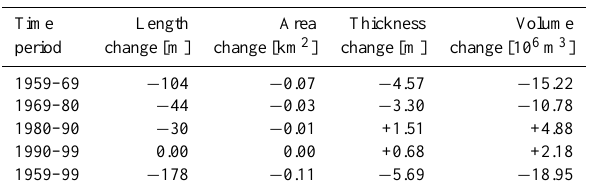
Table 5. Length, area, thickness, and volume changes at Stor- glaci¨aren for given time periods.